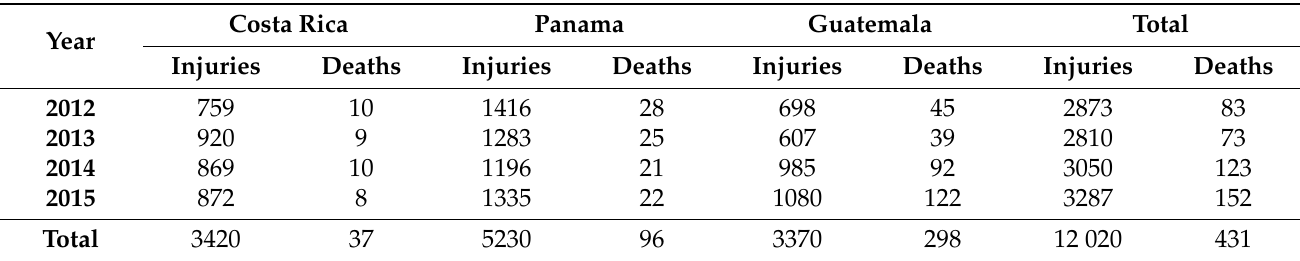
Table 2. Frequency of MVC-related injuries and deaths involving 0 to 14-year-olds in Costa Rica, Guatemala, and Panama 2012–2015.